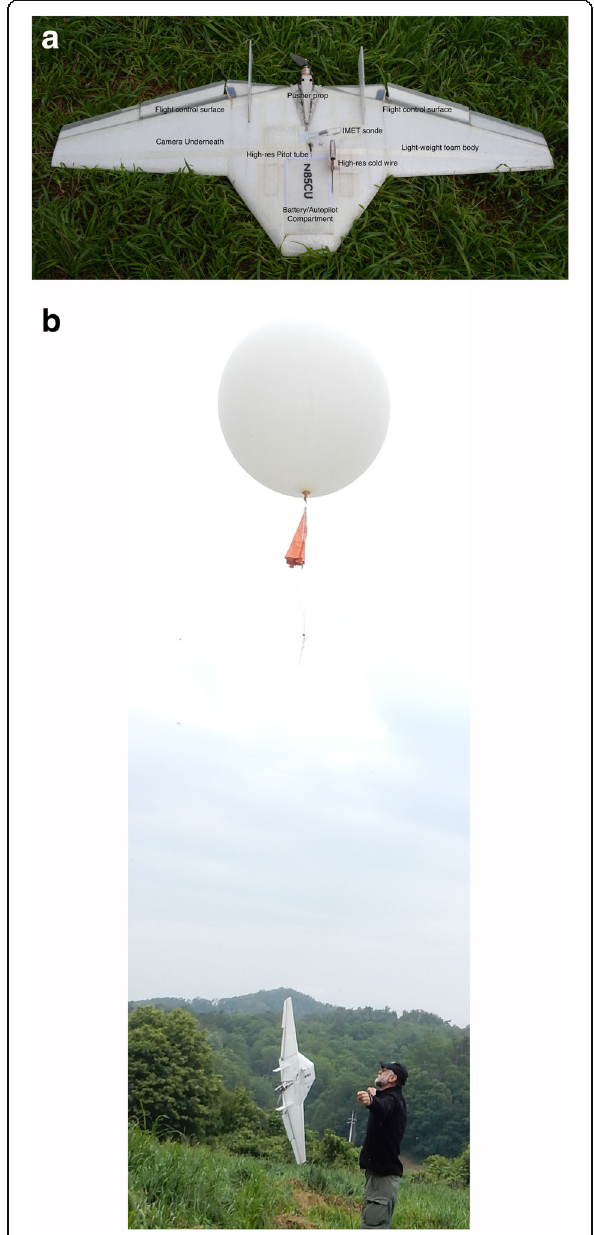
Fig. 2 a The University of Colorado DataHawk UAV. b Balloon